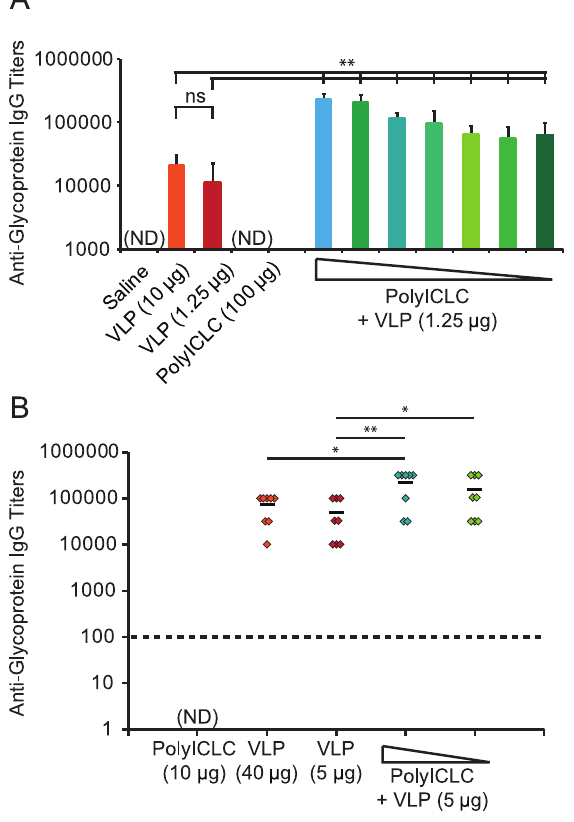
Figure 2. PolyICLC increases VLP-induced EBOV-specific anti- body titers. (A) Peripheral blood was collected from the vaccinated C57BL/6 mice from Figure 1 two weeks after the vaccine boost. Anti- glycoprotein IgG titers in the serum were measured using recombinant glycoprotein as the antigen in an ELISA. (B) Peripheral blood was collected from the vaccinated Hartley guinea pigs from Figure 1 two weeks after the vaccine boost. Anti-glycoprotein IgG titers in the serum were measured using recombinant glycoprotein as the antigen in an ELISA. Dashed line indicates lower limit of detection of assay, which was 1:100 for both A and B. The number of animals is the same as indicated in Figure 1. PolyIC:LC dose levels indicated by triangle are the same as those in Figure 1, and they range from 100 m g to 100 ng in the mouse vaccination studies and 10 m g to 1 m g in the guinea pig vaccination study. P values were determined using the Student’s T-test where ‘‘*’’ indicates p , 0.05 and ‘‘**’’ indicates p , 0.005. ‘‘ns’’ indicates ‘‘not significant’’; ‘‘ND’’ indicated ‘‘not